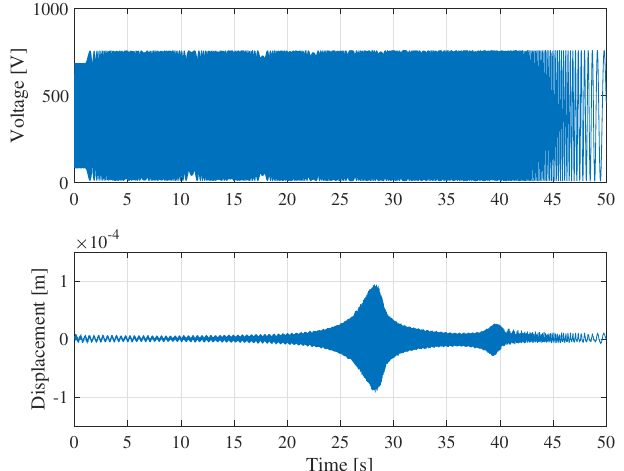
Figure 10. Measured time history of the swept voltage input and the displacement. In this case the frequency range is selected as 1 to 50 Hz. The graph shows the case of weight M = 52.8 g. Based on the obtained time response data, the frequency response from U to Y was estimated by spectral analysis. Figure 11 shows the coherence, gain, and phase in order from the top. The solid blue line is the estimated frequency response. Figure 11 shows the case of weight M = 52.8 g. When the mass of the weight was M = 34.9 g, similar results were observed except that the resonance frequency was high. The frequency response shows good agreement with the typical characteristics of the second-order transfer function shown in Equation (7). A resonance peak of 23 Hz is clearly confirmed from the gain graph in Figure 11. Moreover, as shown in the phase graph in Figure 11, the phase changes smoothly from 0 degrees to 180 degrees near the